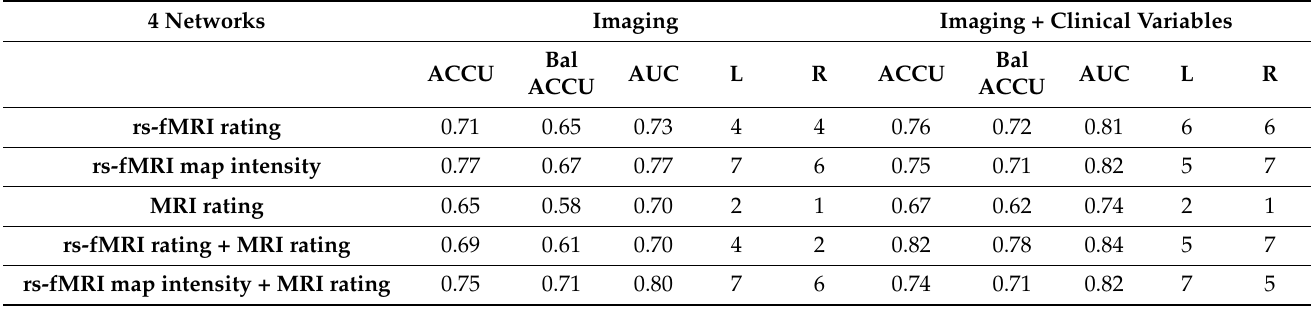
Table 5. Diagnostic accuracy of the five models (multivariate logistic regressions) for the 4 networks. 4